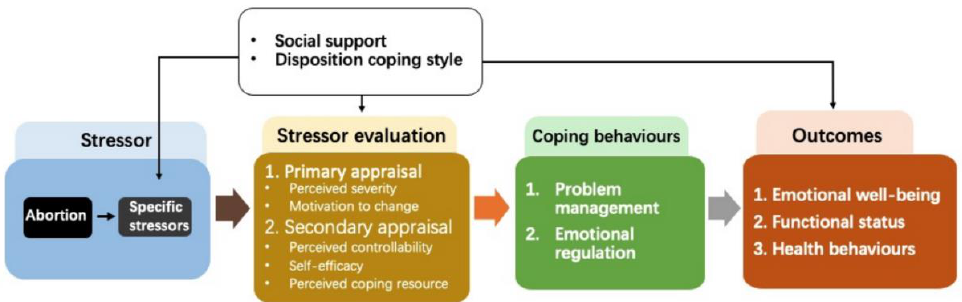
Figure 1. The determinant framework of the START intervention.